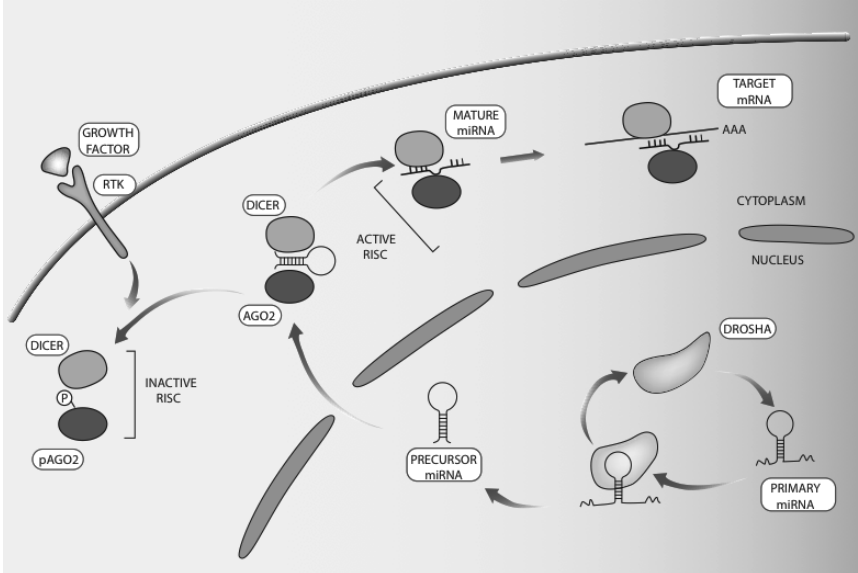
Figure 2. Schematic representation of microRNA biosynthesis and regulation by RTK signaling. microRNA biogenesis starts with transcription of the respective gene by RNA polymerase II. The formed long primary microRNA (pri-miRNA) consists of a hairpin stem, terminal loop and two single stranded regions. The RNase III endonuclease called Drosha processes pri-miRNAs into 70-nucleotide imperfect stem loop structures (pre-miRNAs). The latter are exported to the cytoplasm, to undergo processing by another RNase III endonuclease, Dicer, which removes the loop and joins the two arms. The resulting RNA duplex of 19–24 nucleotides allows one strand to be loaded into the RISC, while the other strand undergoes degradation. Mature microRNAs lead to translational repression or to mRNA degradation. Note that the RISC includes members of the Argonaute family, such as AGO2. It has been reported that phosphorylation of AGO2, at tyrosine 393, by EGFR is enhanced under hypoxia [32]. This is associated with dissociation of the AGO2-Drosha complex and with inhibition of processing of precursor microRNA